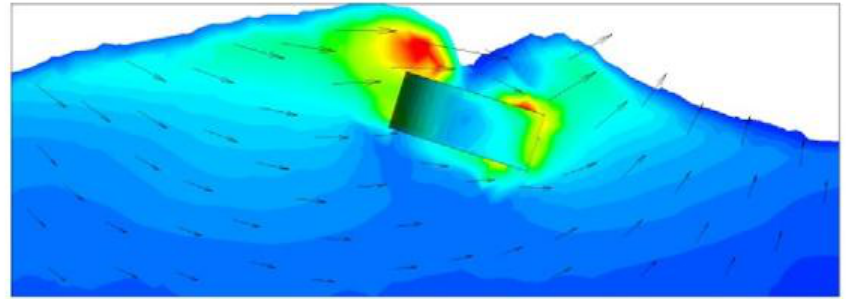
Figure 6. Wave overtopping in an ANSYS Fluent numerical simulation [56] .